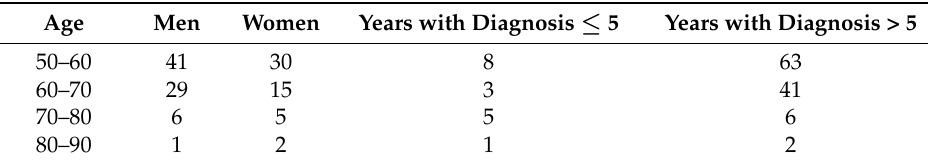
Table 3. Age distribution by gender of the